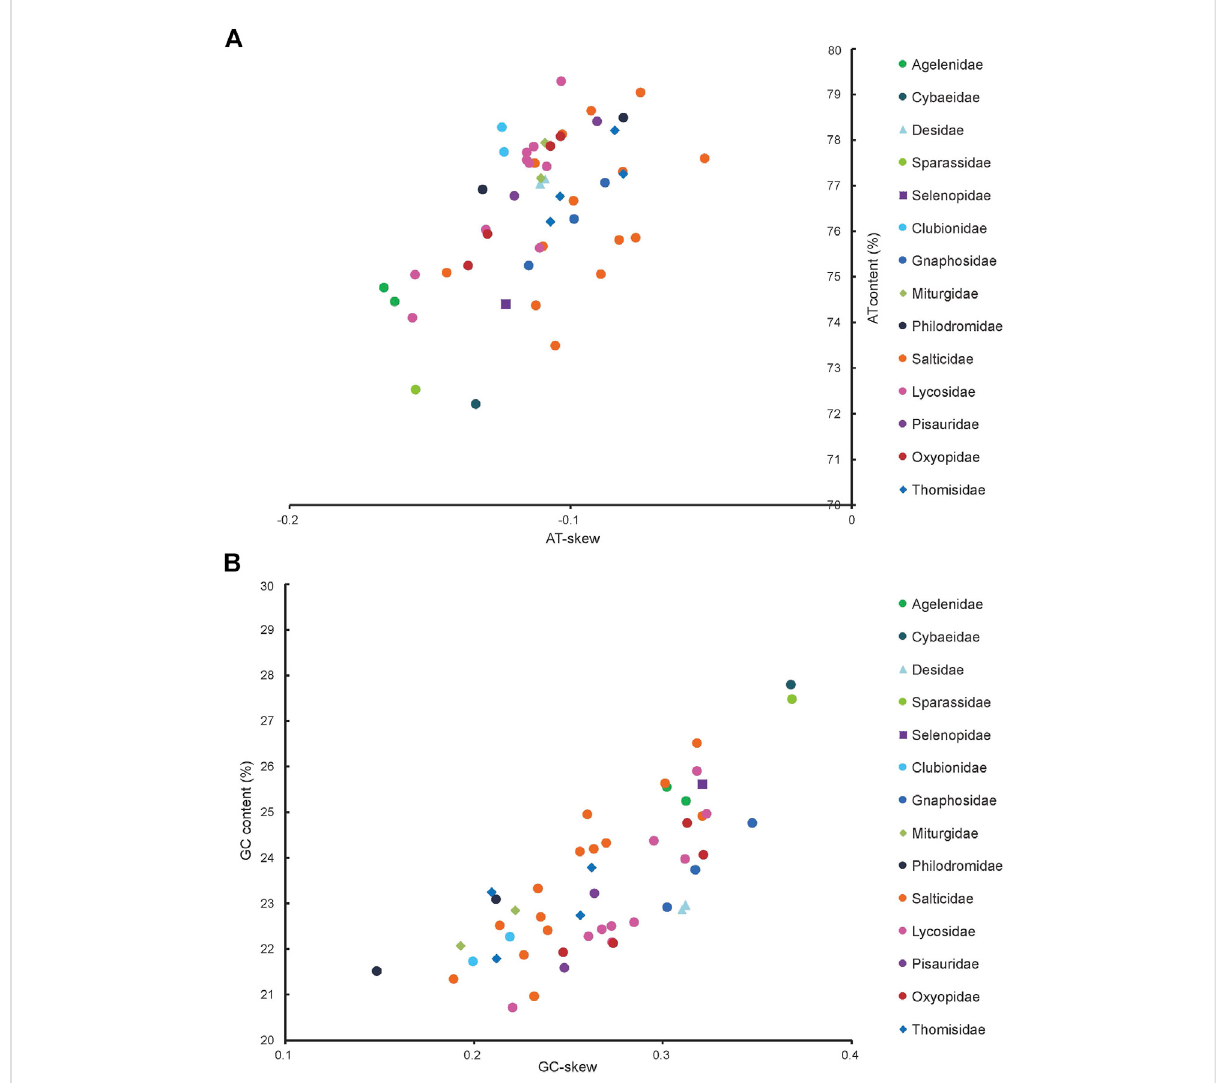
FIGURE 2 AT% vs. AT-skew and GC% vs. GC-skew in the 50 mitochondrial genomes of the retrolateral tibial apophysis clade. Measured in bp percentage ( Y -axis)andlevelofnucleotideskew( X -axis).ValuesarecalculatedonJ-strandsforfull-lengthmitochondrialgenomes. (A) A+T%vs.AT-skew; (B) G + C% vs. GC-skew. See Figure 1 for the full names of the